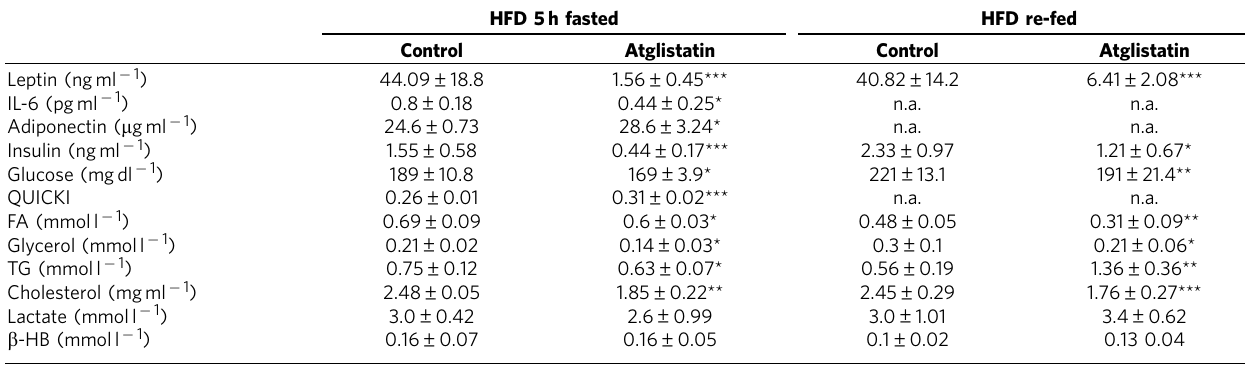
Table 1 | Plasma parameters of mice fed a HFD in the presence and absence of